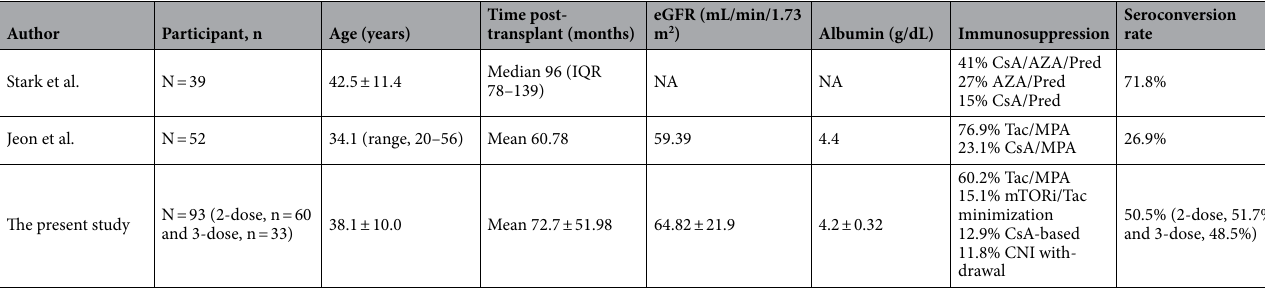
Table 5. Comparison of hepatitis A vaccination studies conducted in kidney transplant recipients. IQR, interquartile range; CsA, cyclosporine A; AZA, azathioprine; Pred, prednisolone; eGFR, estimated glomerular filtration rate; Tac, tacrolimus; mTORi, mammalian target of rapamycin inhibitor; MPA, mycophenolic acid; CNI, calcineurin